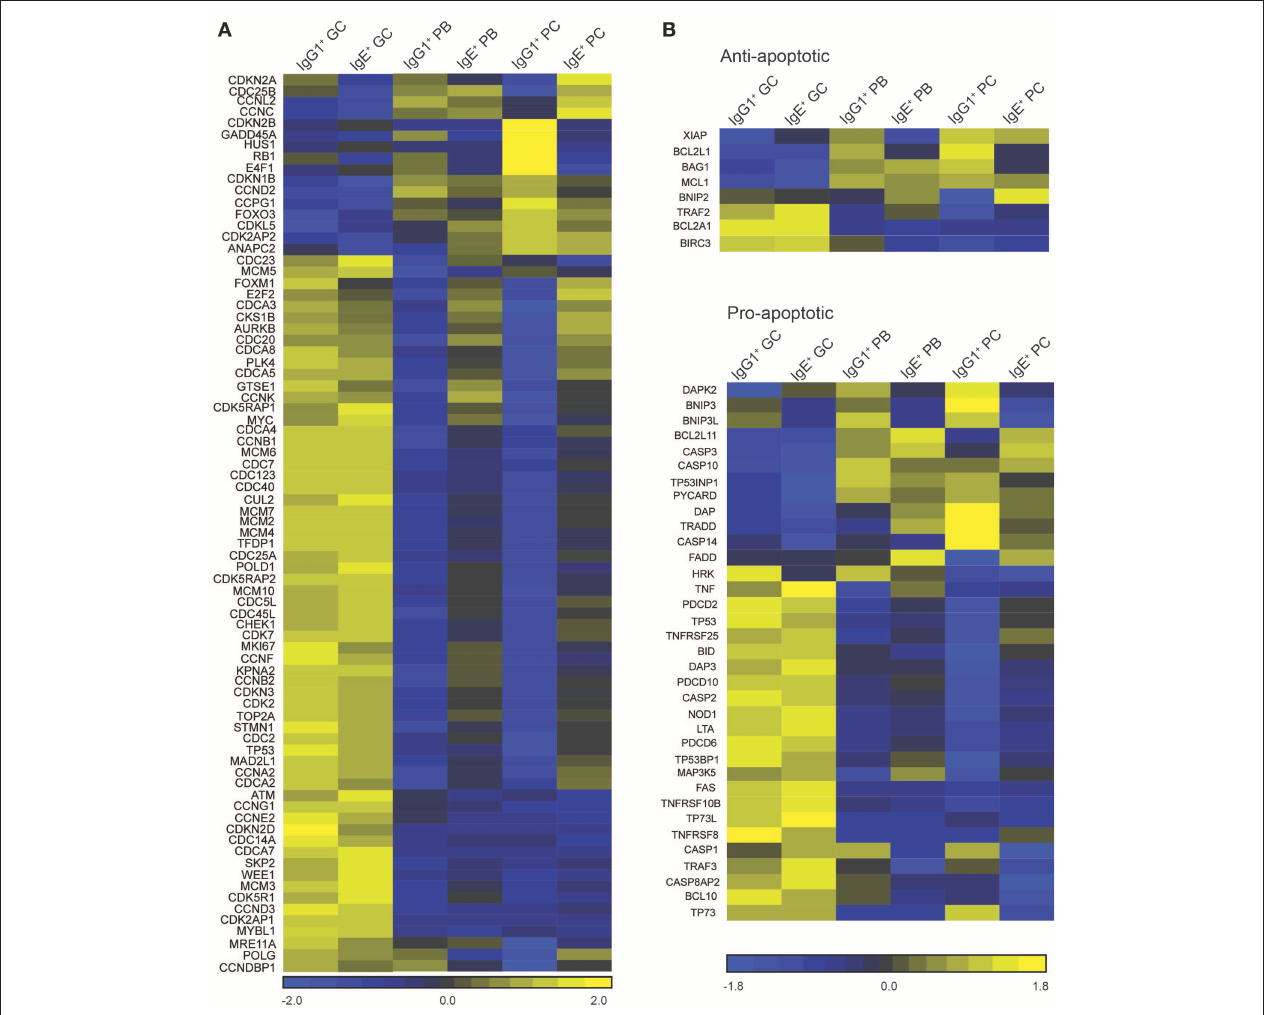
FIGURE 5 | Cell cycle/proliferation-associated genes differentially expressed in IgE + and IgG1 + cells. (A) Heatmap of cell cycle/proliferation-associated and (B) pro- and anti-apoptotic genes differentially expressed along the PC differentiation pathway of both IgE + and IgG1 + cells, and differentially expressed in IgE + cells compared to IgG1 + cells. Each column in the heat maps shown represents the mean gene expression profile from all four donors of the specified phenotypic